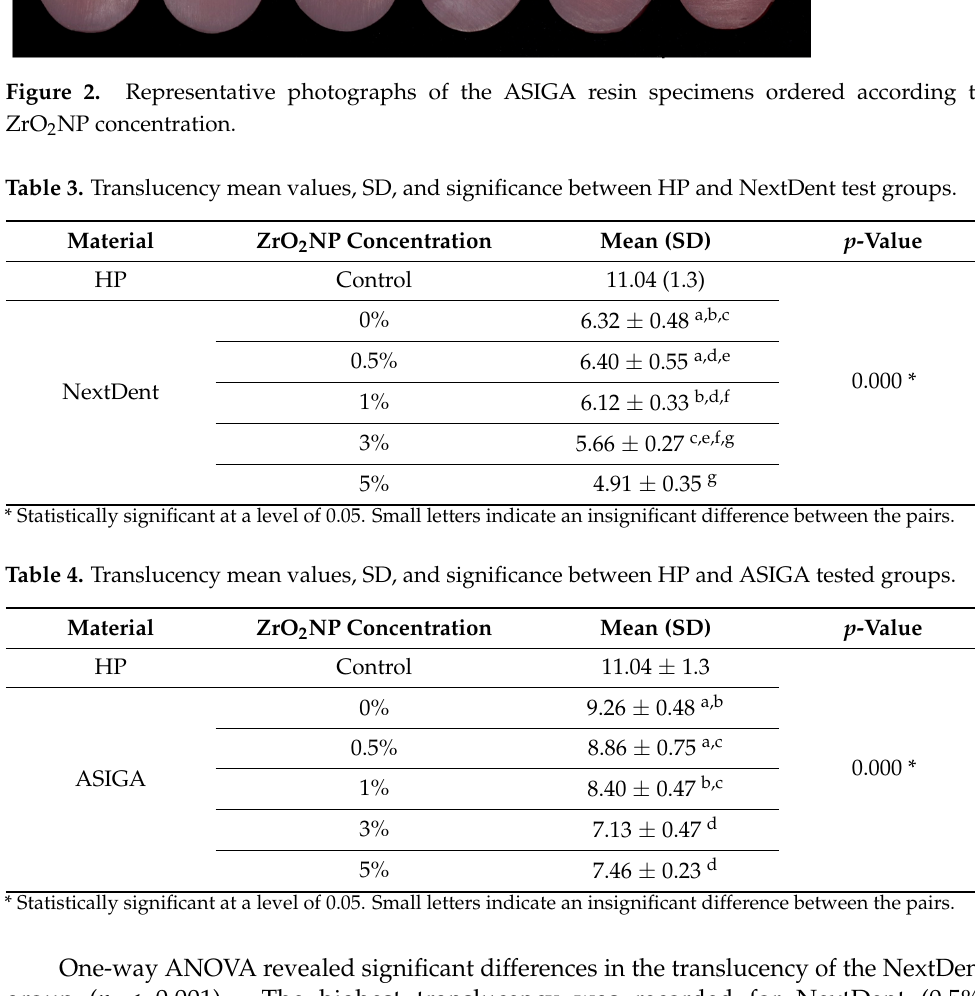
Table 4. Translucency mean values, SD, and significance between HP and ASIGA tested groups.